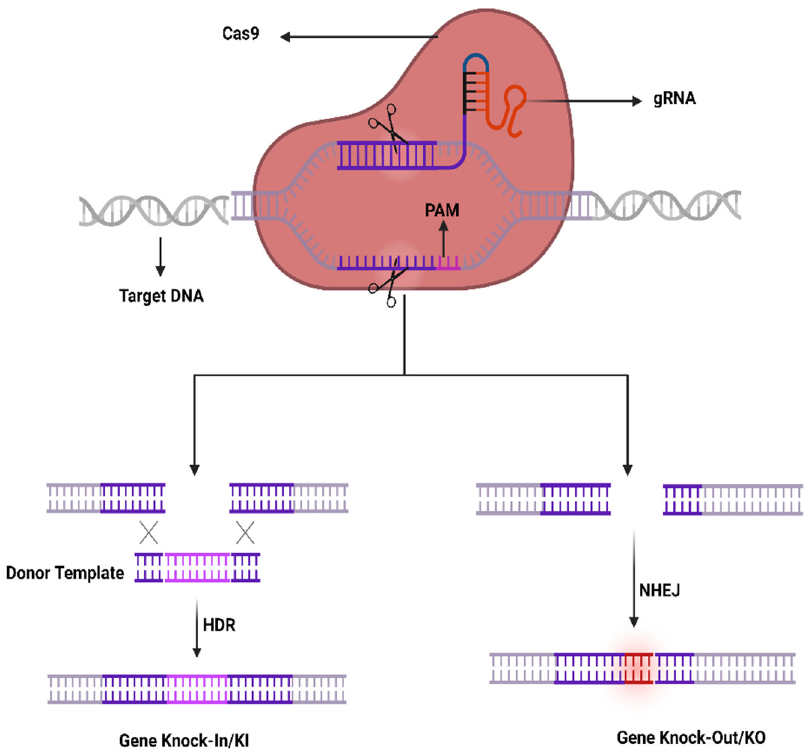
Figure 1. CRISPR/Cas9 working mechanism.